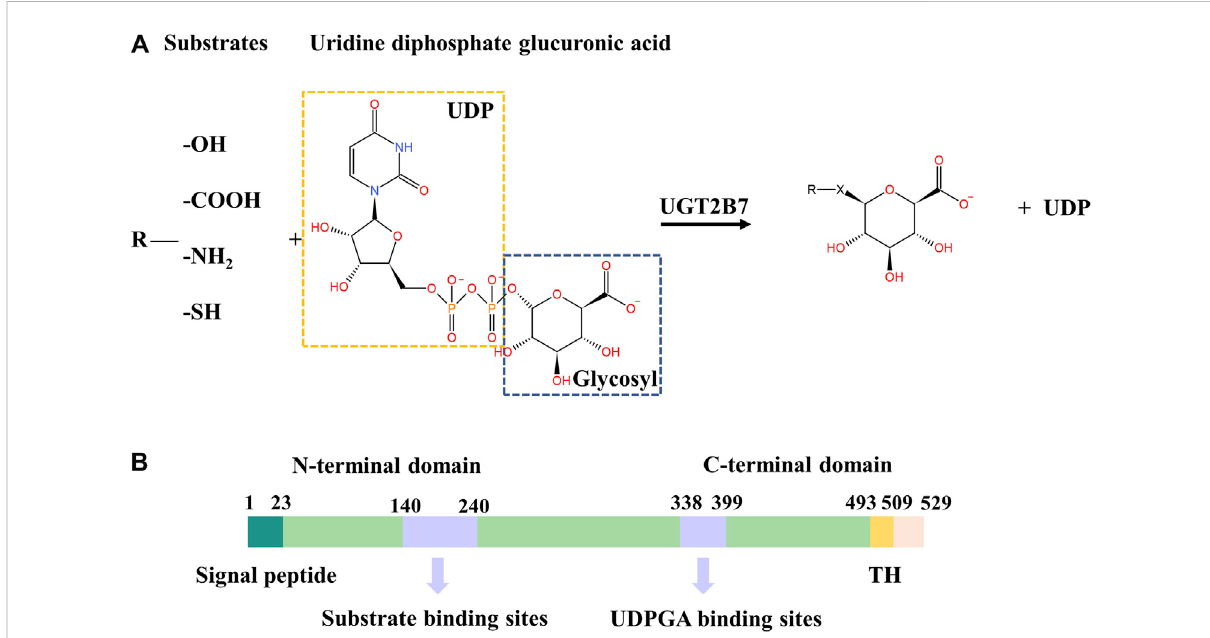
FIGURE 1 (A) Conjugation reaction catalyzed by UGT2B7. X represents -O - , -COO - , -NH + , -S - . (B) Color-coded domain architecture of human UGT2B7. The numbers represent the residue positions of the wide-type UGT2B7 counted from the N-terminus. The locations of the substrate and UDPGA binding sites are indicated in purple. TH, transmembrane